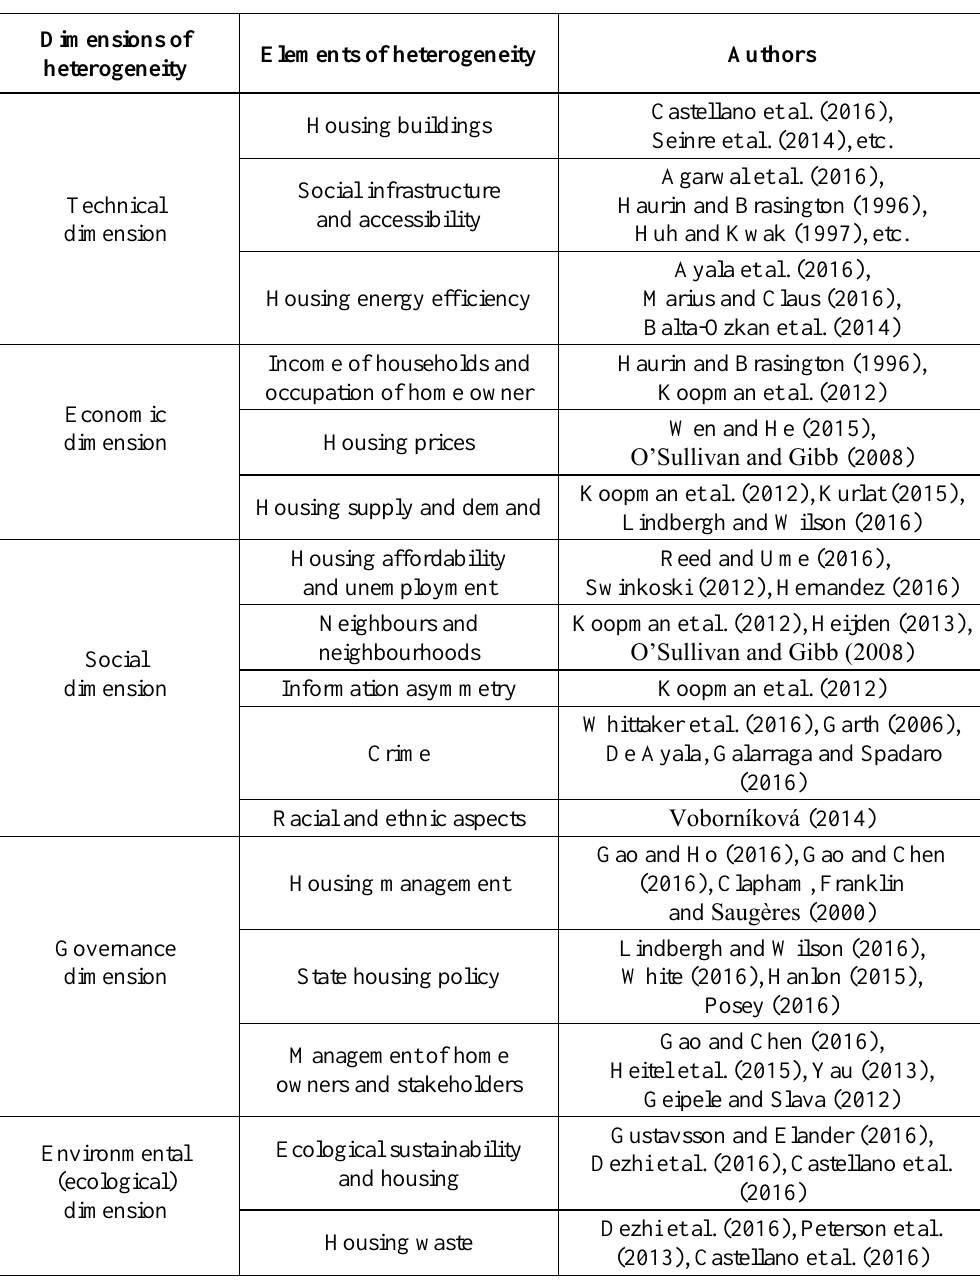
Table 1. Studies on the Housing and/or Housing Market Heterogeneity (table developed by the authors on the basis of the research